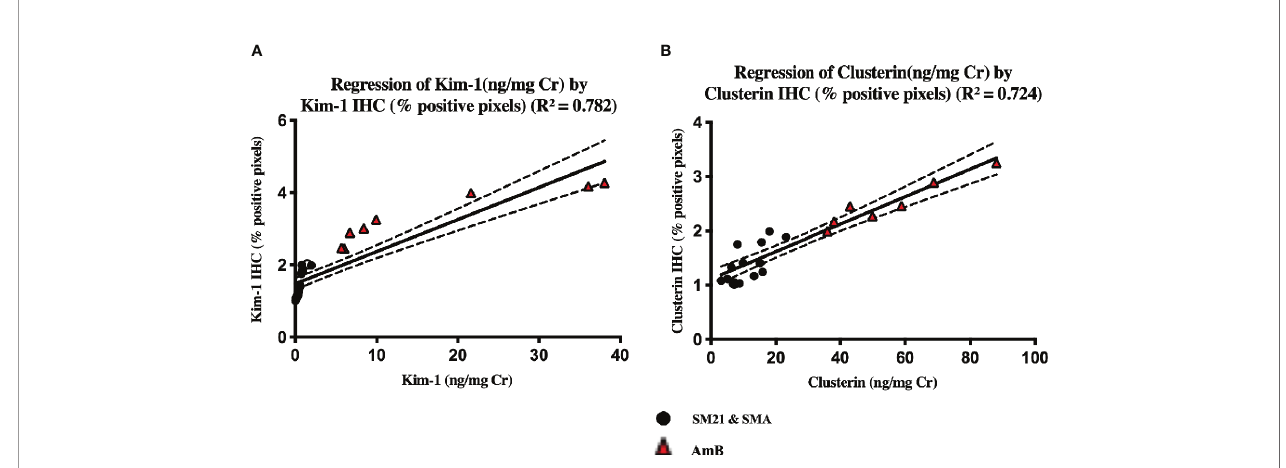
FIGURE 9 | There was a signi fi cant level of correlation between tissue (x-axis) and urinary (y-axis), (A) Kim-1 and (B) Clusterin from individual animals on the day 5. Vehicle, SM21 and SM21 analogue treated rats had little to no urinary expression of protein nor protein immunoreactivity within the kidney, whereas AmB-treated rats had higher levels of both urinary protein expression and immunoreactivity observed within the kidney. The line of best following linear regression of Kim-1 and clusterin are shown (R 2 = 0.782) and (R 2 = 0.724), respectively. The IHC optical density score calculation (Image J) of the each zone is assigned as 4 for the high positive zone, 3 for the positive zone, 2 for the low positive zone, and 1 for the negative zone. IHC, immunohistochemistry; Kim-1, Kidney Injury molecule-1; SMA, SM21